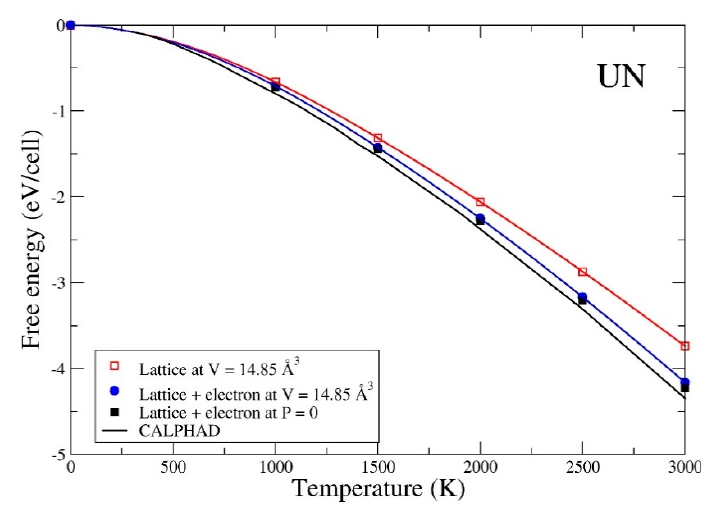
Figure 2. DFT and CALPHAD (from 300 K) free energies for UN. Open squares refer to SCAILD lattice energies at constant atomic volume (14.85 Å 3 ). The DFT electron free energy that includes electronic entropy was added for the solid circles. The solids squares refer to results from volume relaxation (pressure is zero) that includes both electronic and lattice contributions. The lines connecting the symbols are guides to the eye only. The solid line without symbols refers to our CALPHAD results.